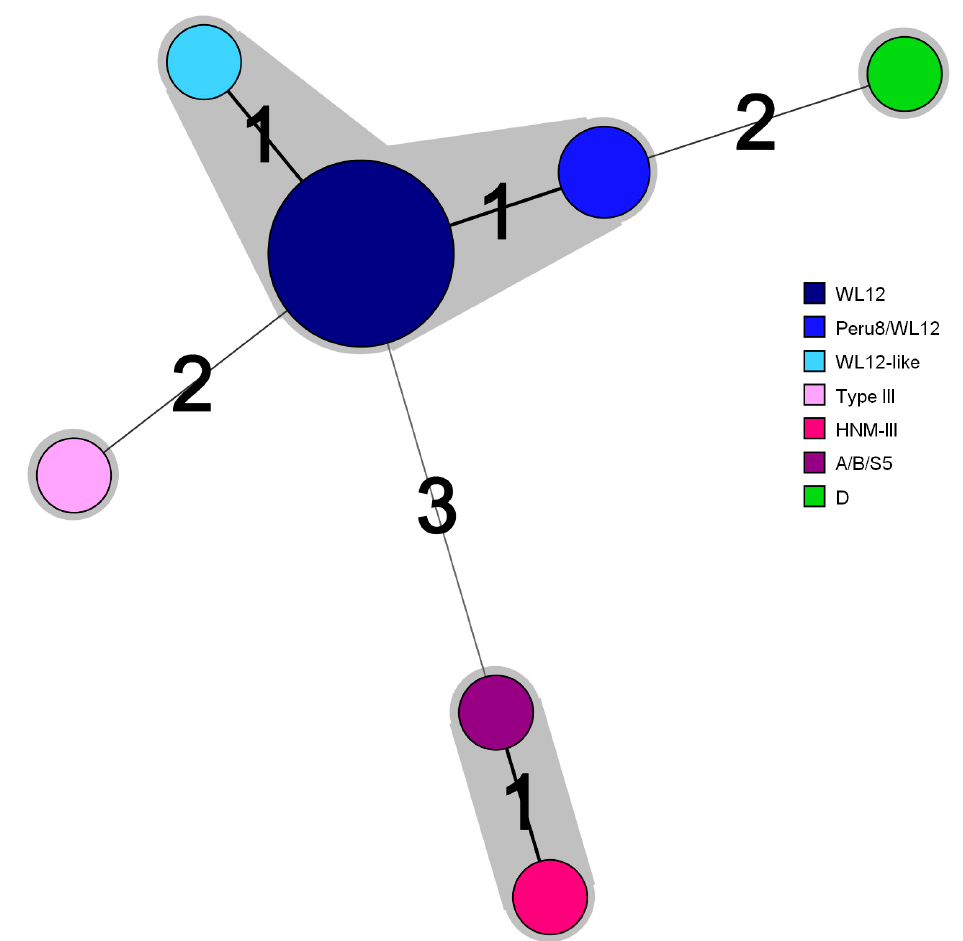
Figure 2. Minimum-spanning tree profile of ITS sequences from E. bieneusi strains infecting intestinal microsporidia-positive patients. Each node corresponds to a distinct genotype, indicated on the legend with a color code (right side). The size of the spheres is proportional to the number of strains sharing the same genotype. The shaded zones (light gray) indicate clusters of similar ITS genotypes (i.e., ITS sequences with no more than one nucleotide difference). Numerals connecting the circles indicate the number of single nucleotide polymorphisms that differentiate a given genotype from another.